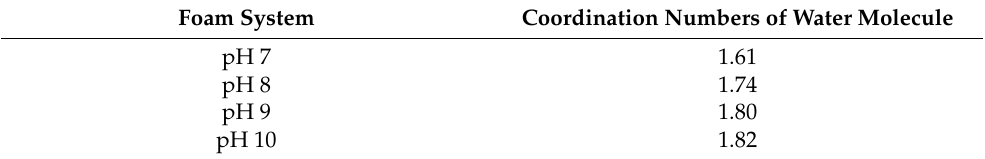
Table 3. Coordination numbers of water molecules in the hydration shells of foam systems with different pH.